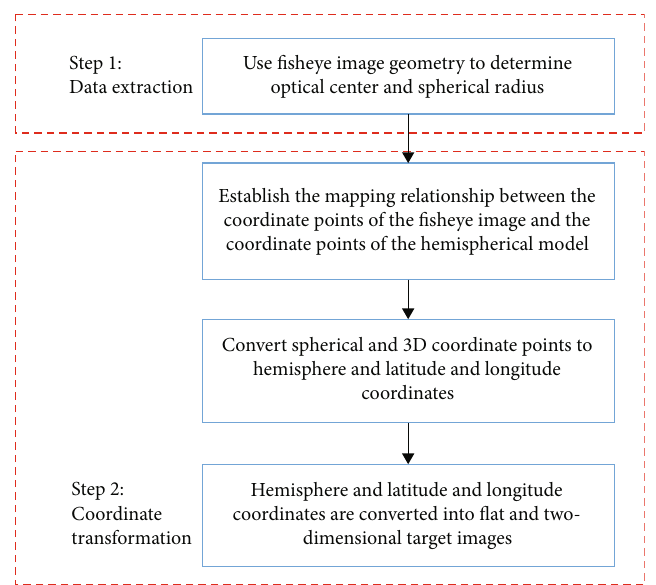
Figure 1: Process of fi sheye correction method.